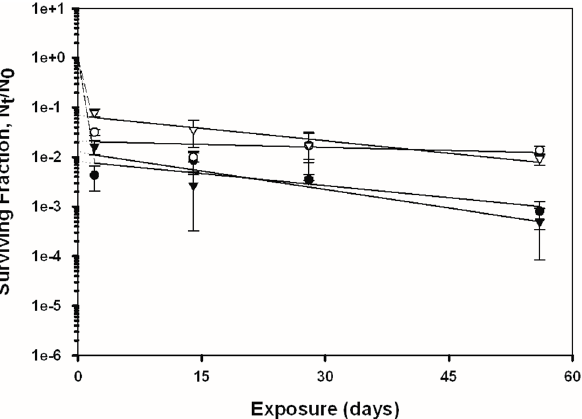
Fig 3. Inactivation curves of B . subtilis and B . anthracis spores on bare pine wood. Circles represent B . subtilis , triangles represent B . anthracis , shaded symbols represent coupons exposed to UV, and non- shaded symbols represent the coupons that were not exposed to UV. The data points and error bars are the averages and standard deviations of results from five replicate coupons. The surviving fraction of spores after each experiment was calculated by N t /N 0 , where the viable spore titer at any given time point ( N t ) was divided by the initial spore titer ( N 0 ). Dashed and solid lines represent the initial (first phase) and final (second phase) slopes of the curve, respectively.